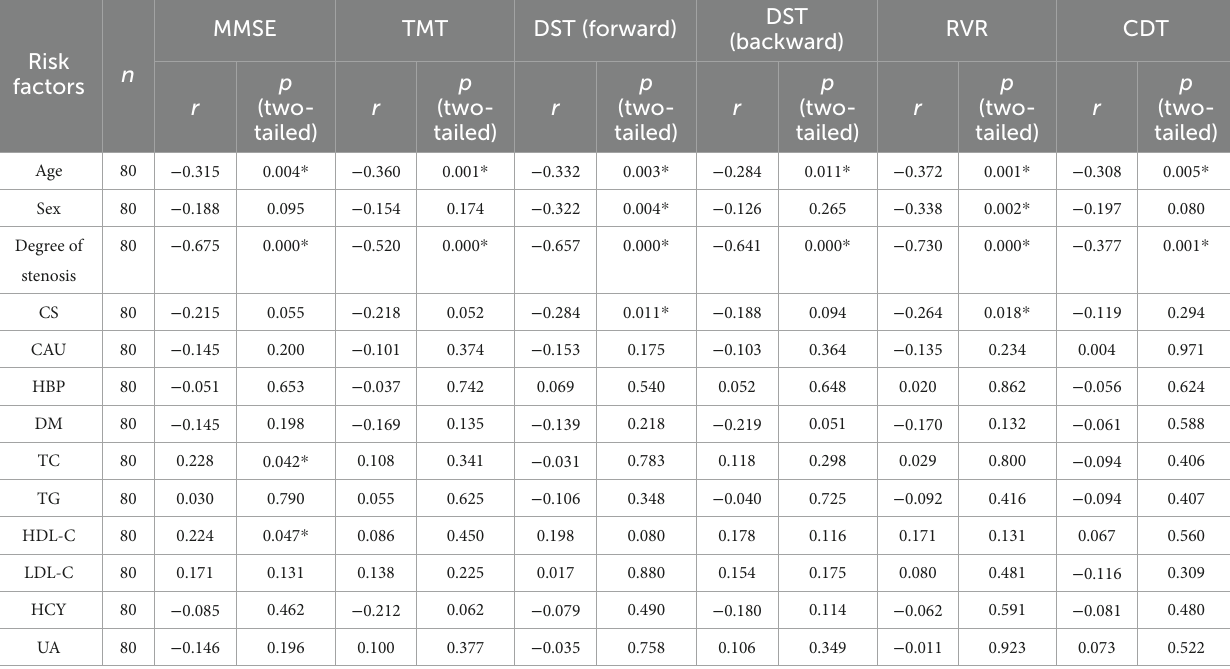
TABLE 4 Pearson correlation analysis between vascular risk factors and impaired cognitive function in asymptomatic patients with right carotid artery stenosis.